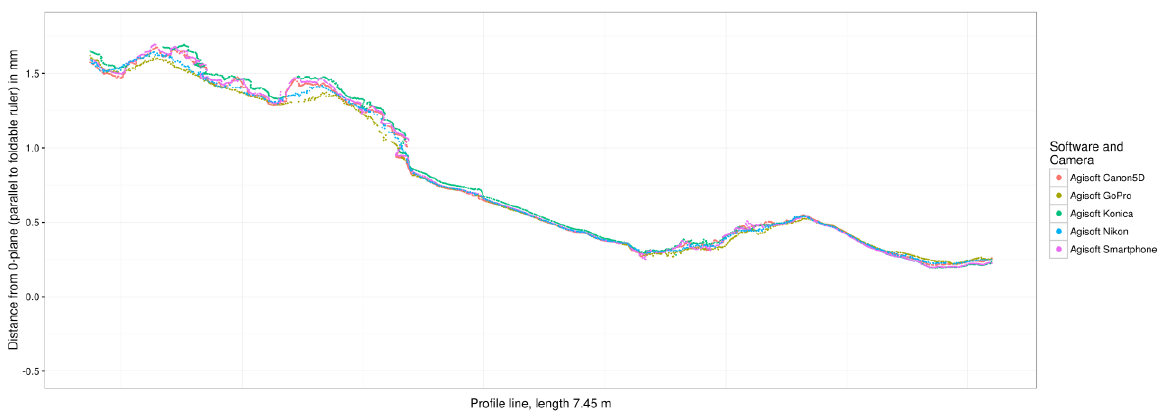
Figure 26. Profile lines produced by Agisoft PhotoScan for different